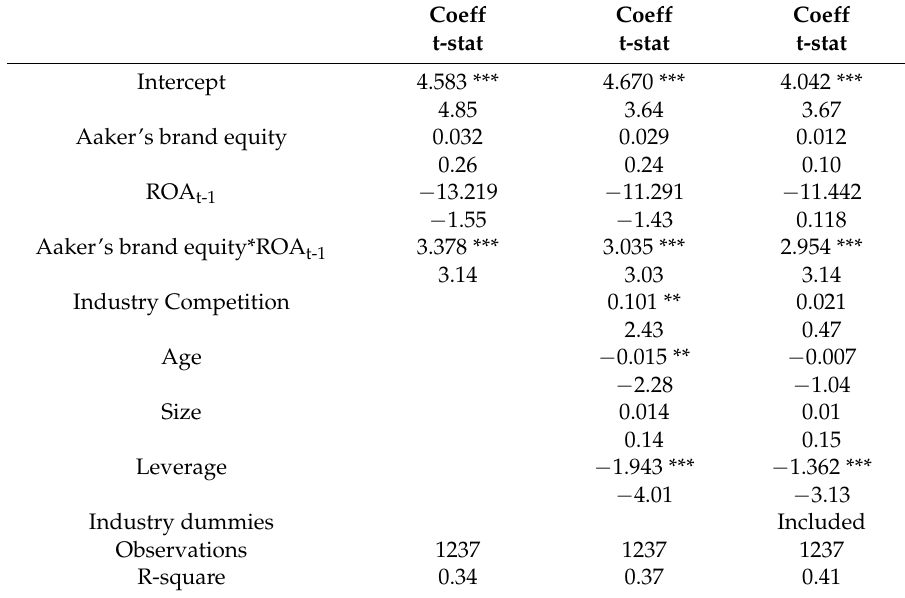
Table 6. Sensitivity analyses. Brand equity and persistence of